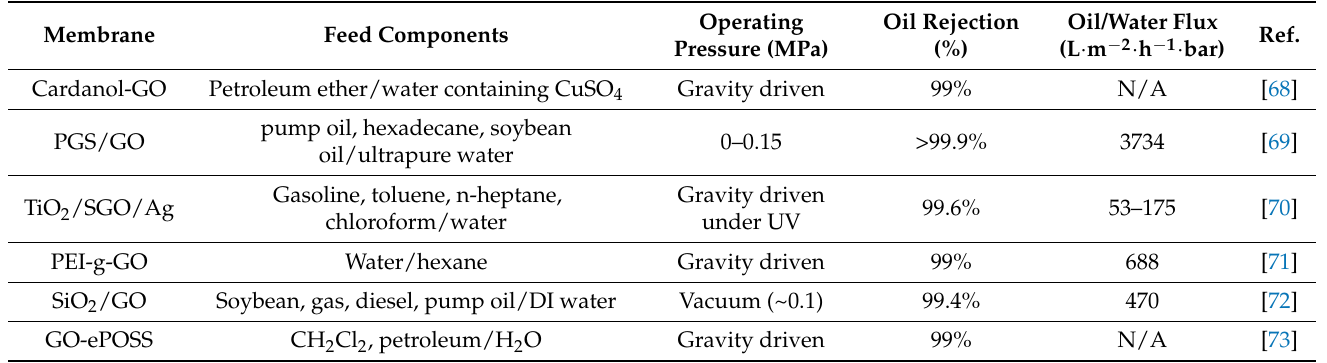
Table 2. Oil rejection efficiency of some graphene-based membranes in several oil/water